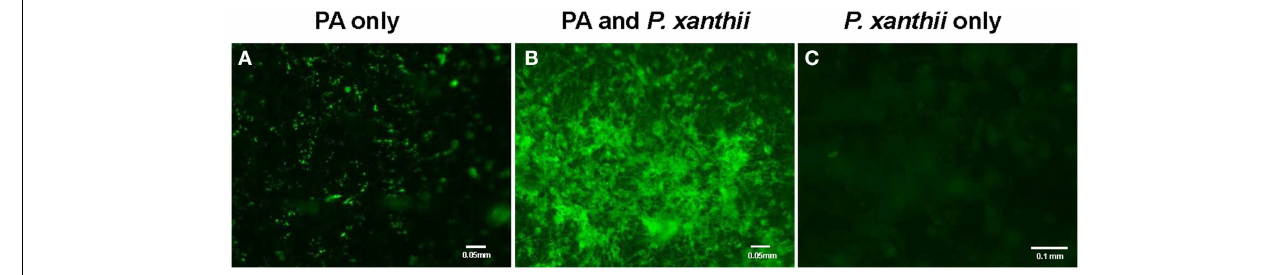
FIGURE 1 | Imaging of P. aphidis proliferation on infected cucumber cotyledons. Fluorescence microscopy analysis of cucumber cotyledons treated with GFP-tagged P. aphidis (A) followed by successive inoculation (3 days after P. aphidis treatment) with P. xanthii (B) or treated with water and